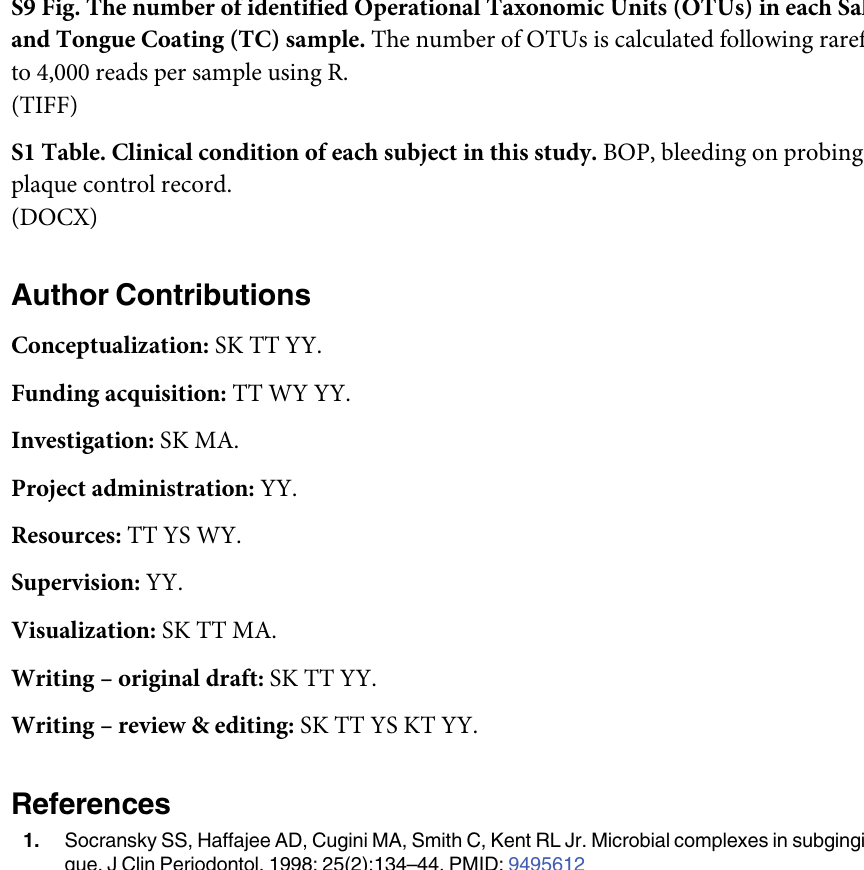
S8 Fig. Total relative abundances of the 22 OTUs that are characteristically predominant in supragingival plaque samples in the pre-therapy samples from each niche. The mean rel- ative abundance in each niche is represented by a line and a number. S9 Fig. The number of identified Operational Taxonomic Units (OTUs) in each Saliva (SL) and Tongue Coating (TC) sample. The number of OTUs is calculated following rarefaction to 4,000 reads per sample using R. S1 Table. Clinical condition of each subject in this study. BOP, bleeding on probing; PCR, plaque control